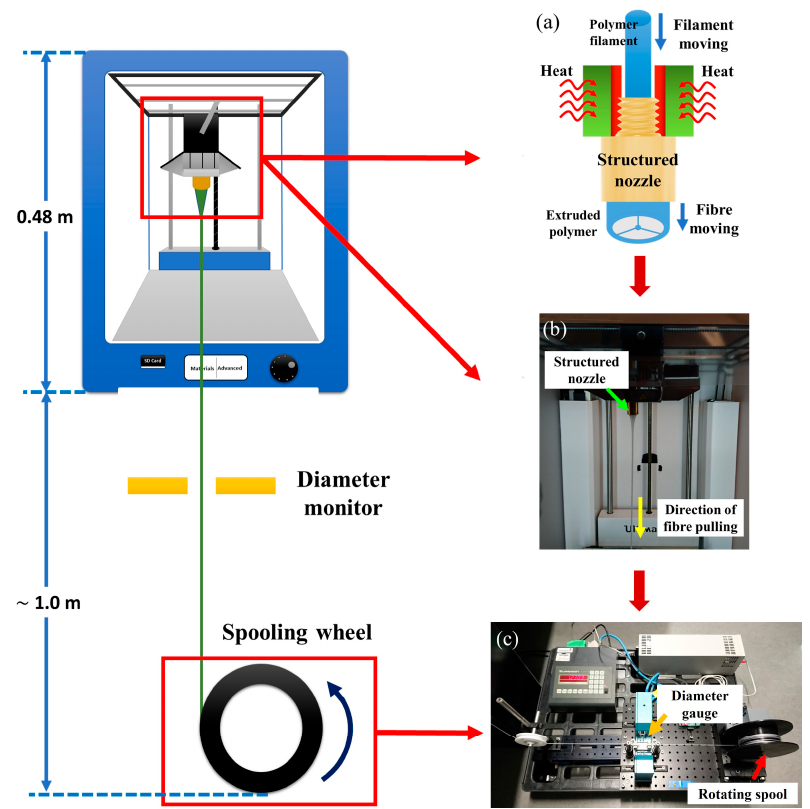
Figure 9. ( a ) Schematic of the experimental setup used to extrude the suspended-core MPOF. ( b ) Fiber drawn from the heated structured nozzle. ( c ) MPOF wrapped onto the 3D printed spool connected to the stepper motor.